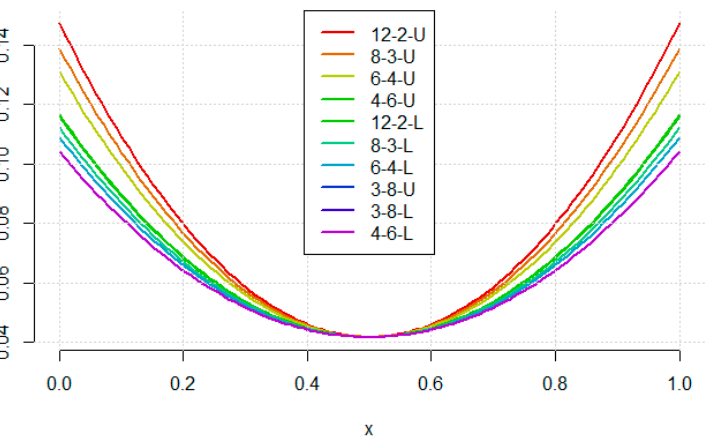
Figure 3. The prediction uncertainty shape for the linear model with the considered designs. For the abbreviations see text in Section 3.